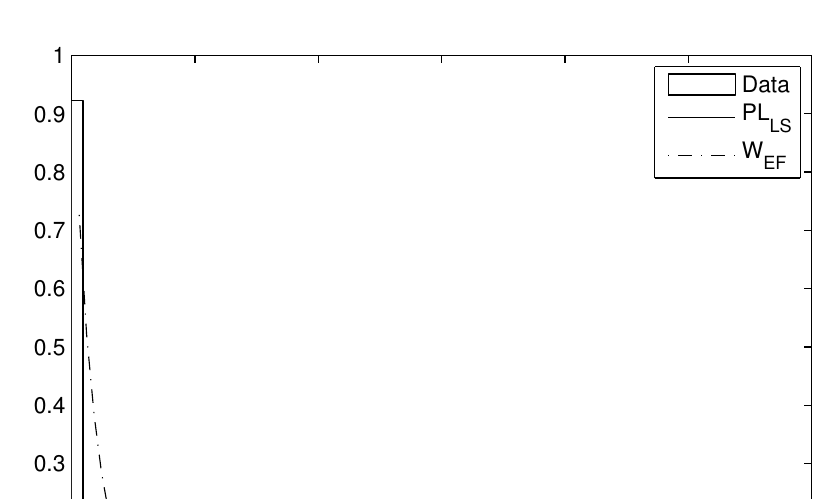
Figure 2. Fitted distributions for NOC-system